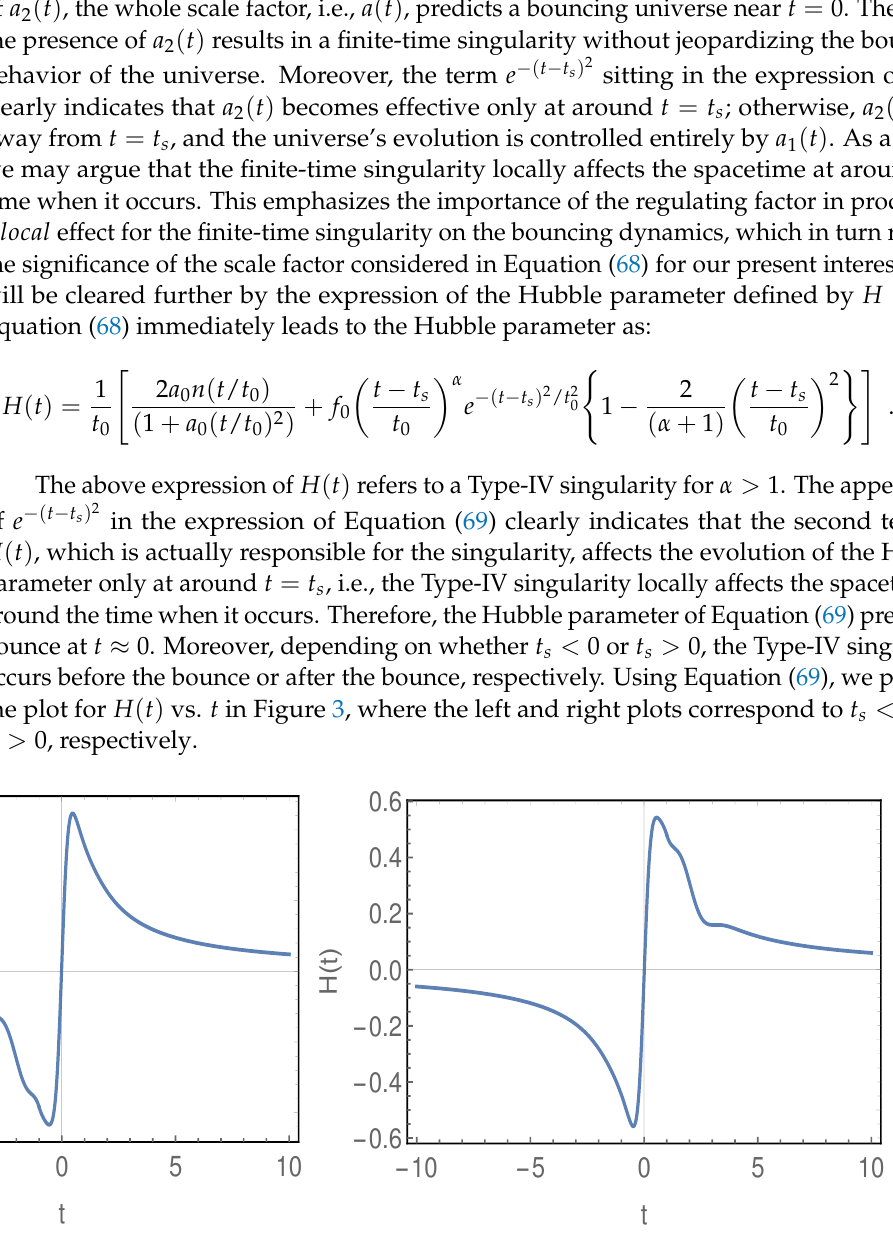
Figure 3. H ( t ) vs. t from Equation (69). Here, we take n = 0.3, a 0 = 4, α = 5/3, and f 0 = 1. The left and right plots correspond to t s = − 1 By and t s = 1 By, respectively. Moreover, t 0 is taken to be 1 By to make all the time coordinates in the unit of Billion year (By). Such values for the parameters lead to the consistency of the observable quantities with the Planck data, in the case when the Type-IV singularity locally affects the spacetime (see Figure